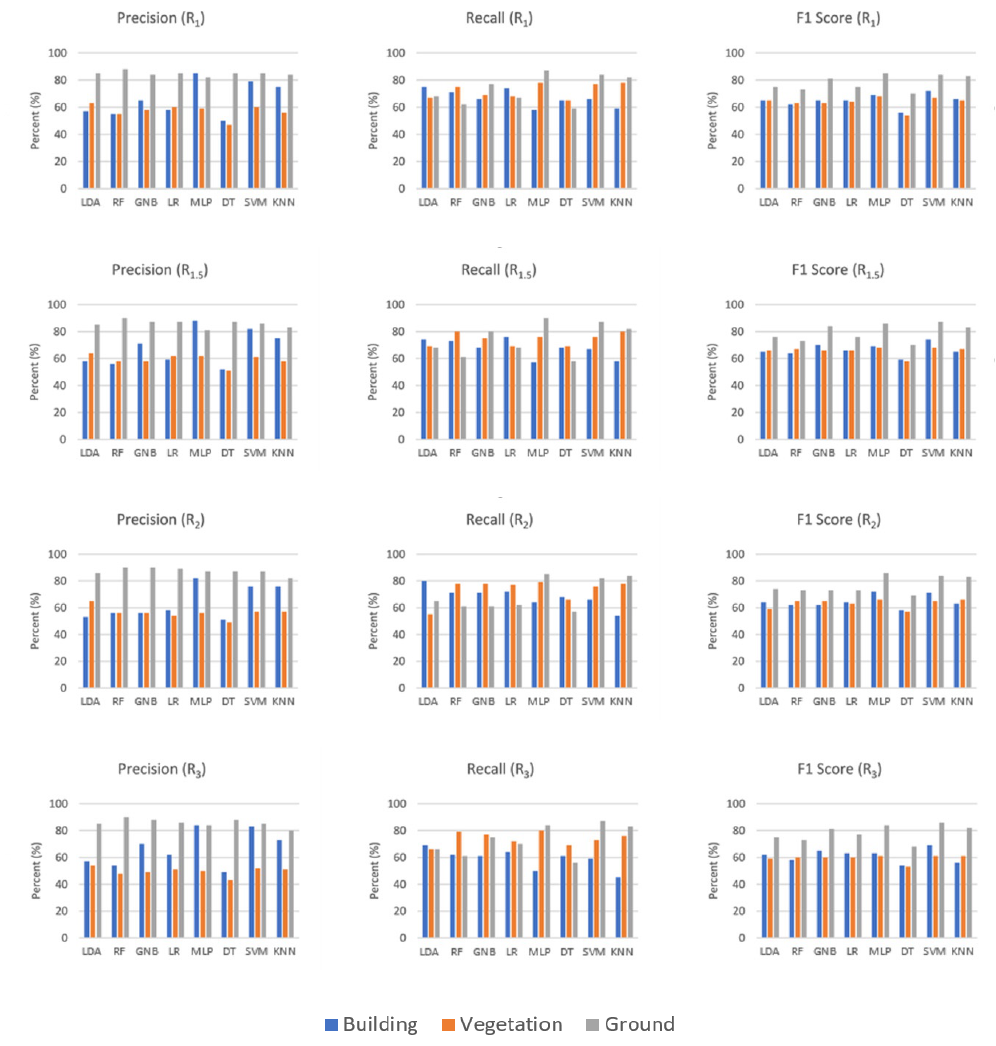
Figure 14. Precision, recall and F1 score values of the algorithms for Vaihingen. In the Oakland3D dataset, it was determined that better results were obtained in R 1 and R 1.5 supports. As with the Vaihingen dataset, recall values were higher than precision values at all scales. Especially in R 2 and R 3 supports, a decrease was observed in all accuracy metrics. Similar to other datasets, insufficient accuracy was obtained in R 05 support. For building class, while the highest F1 score was obtained with LDA (88% in R